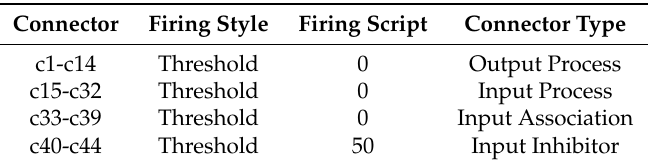
Table 4. Connectors in the HFPN model.